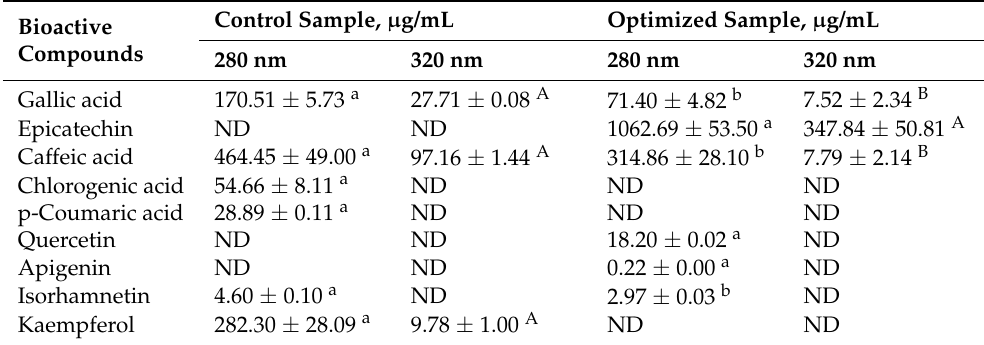
Table 8. Phenolic acids and flavonoids’ content of the fermented product obtained under optimized biotechnological